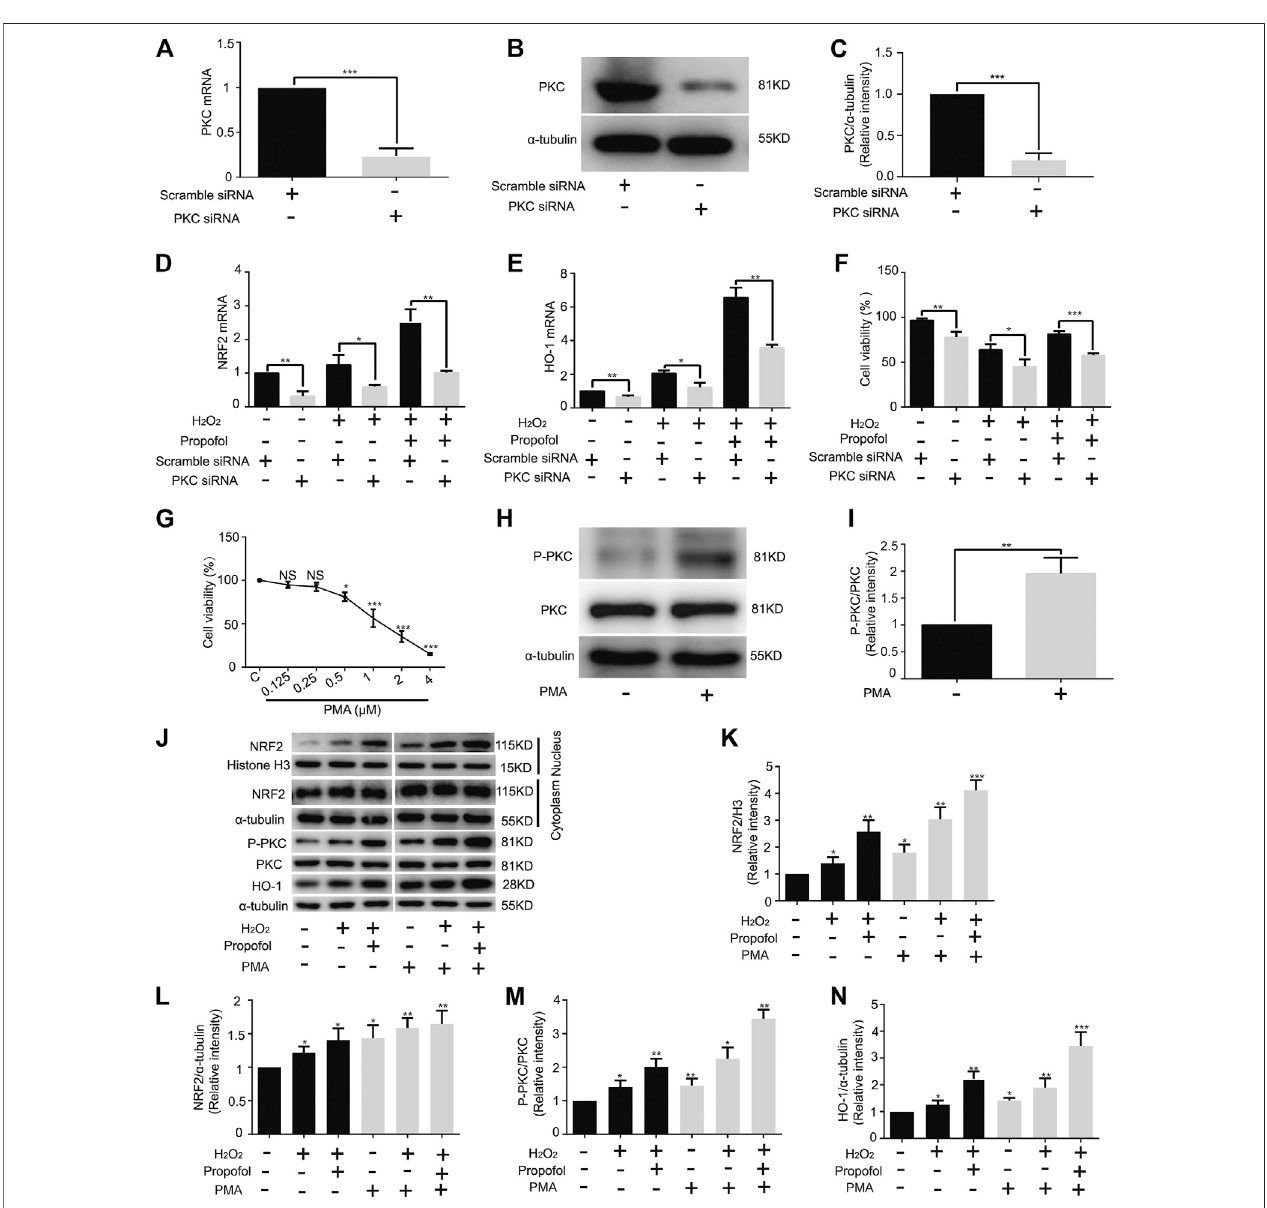
FIGURE 4 | In fl uence of propofol on PKC knockdown and overexpression in H9C2 cells. Expression of PKC mRNA (A) and protease (B,C) in H9C2 cells transfectedwithPKCandscramblesiRNA.LevelsofNRF2 (D) andHO-1 (E) mRNAsinH9C2cellstransfectedwithascrambleandPKCsiRNA. (F) .In fl uenceofpropofol onH9C2cellviabilityofPKCknockdownunderoxidativestresscondition. (G) .ViabilityofH9C2cellstreatedwithphorbol12-myristate13-acetate(PMA,0 ∼ 4 µM). (H,I) . Expression of PKC in H9C2 cells treated with 0.5 µM PMA based on western blot assay. (J – N) . In fl uence of propofol on H9C2 cell PKC, NRF2 and HO-1 expressionsofPKC overexpression under oxidative stress condition. Data areexpressed asthe mean ± SD. Signi fi cance wascalculated using theANOVA or Student ’ s t-test. p < 0.05 was considered statistically signi fi cant. * p < 0.05, ** p < 0.01, *** p < 0.001.